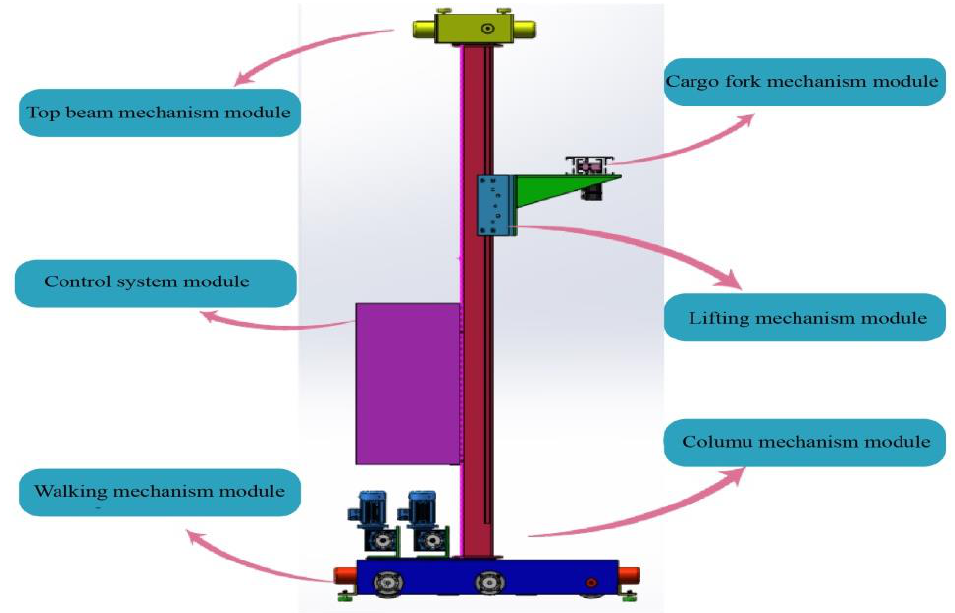
Figure 3. A parameterized small rail roadway stacker model.